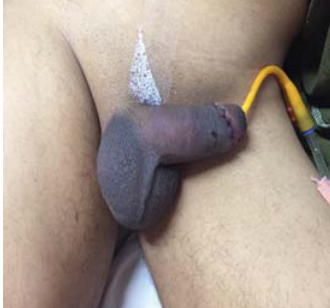
Figure 5. After 48 hours, the penile appearance is